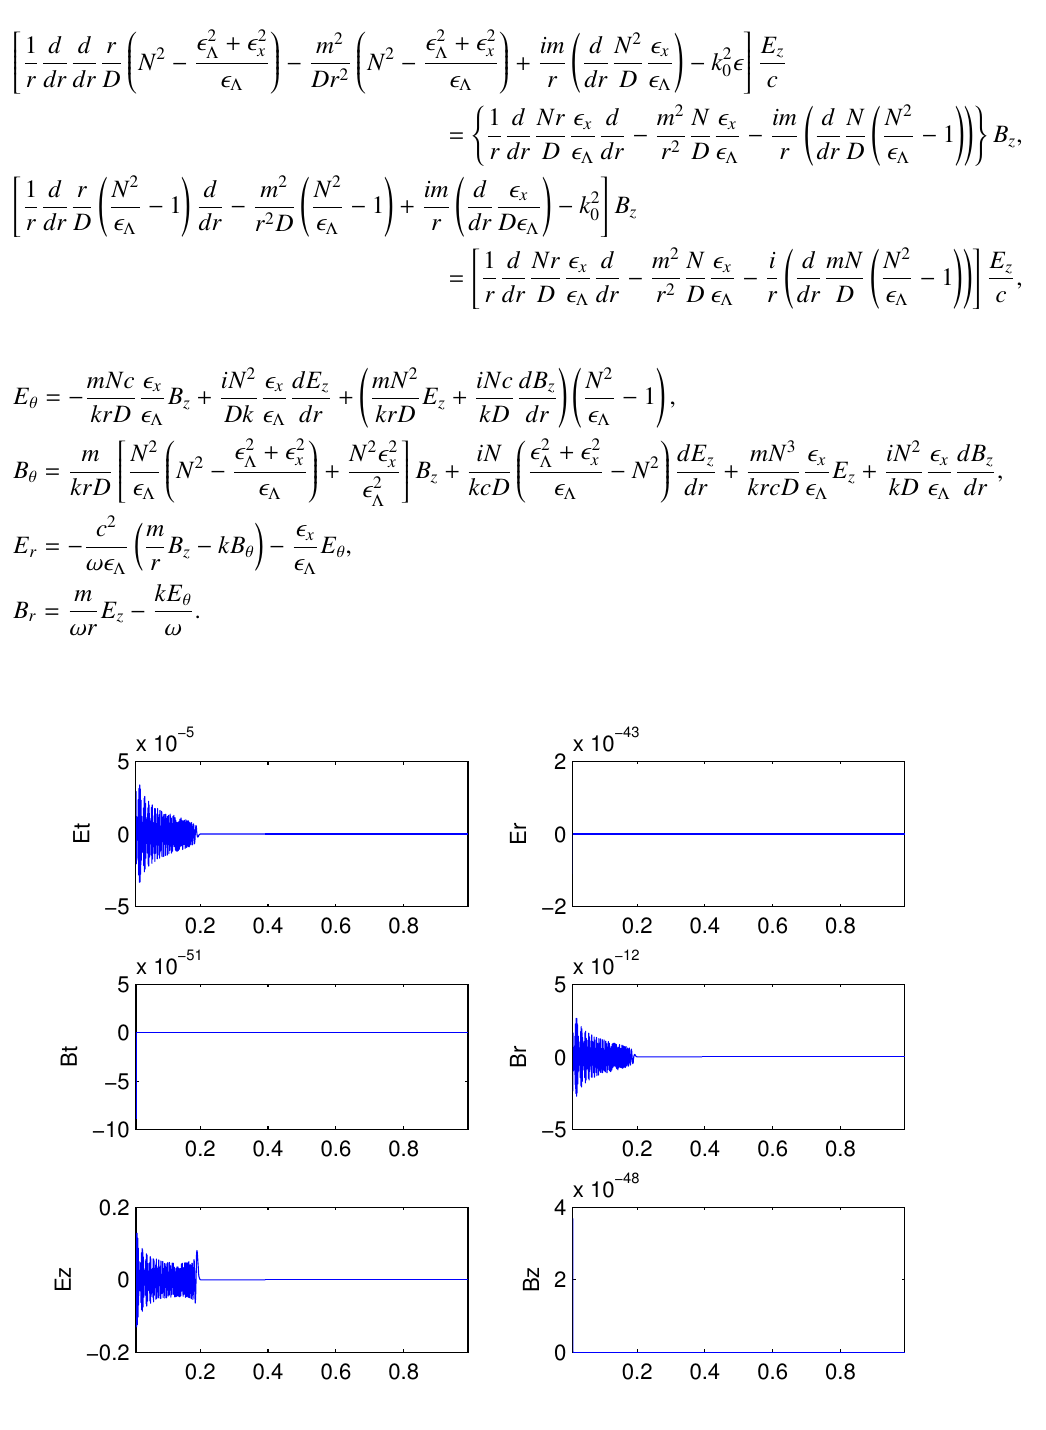
Figure 8: r , θ and z components of electric field E and magnetic field B with respect to the normalized minor radius r for cavity mode with ( m , n ) = (0 , 140), shows that the mode is localized in plasma center and it is quasi-static electric mode. The mode number n is defined to be the number of zero E z with respect to r direction.